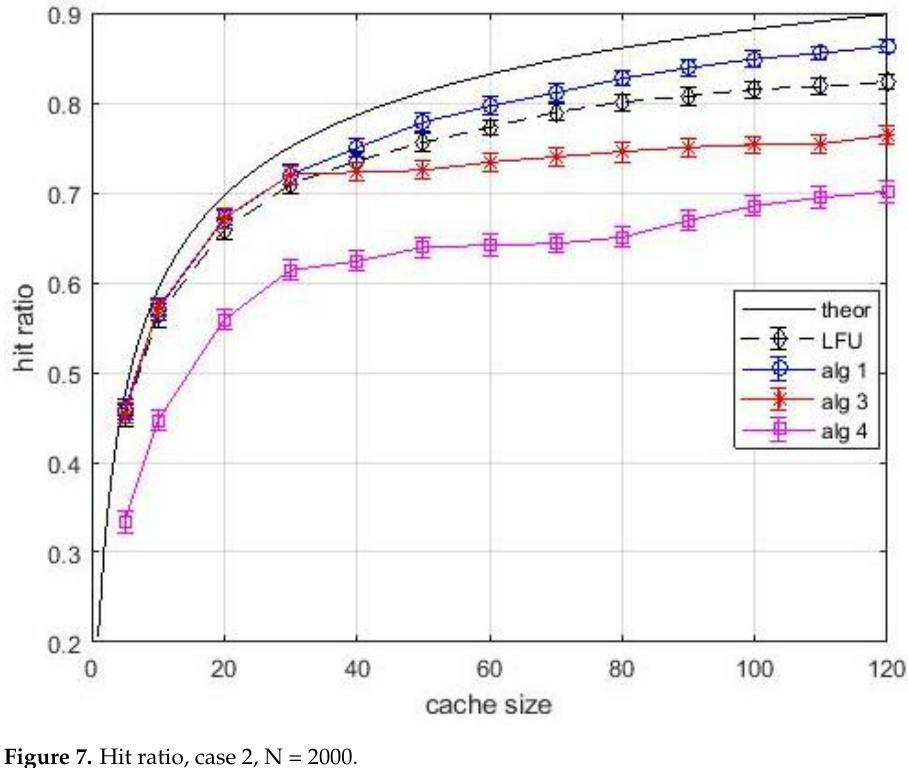
Figure 7. Hit ratio, case 2, N = 2000.